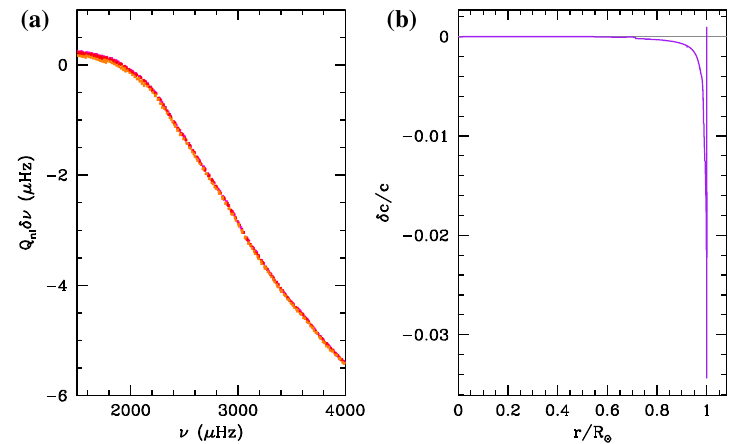
Fig. 8 a The scaled frequencies differences between a solar model constructed with the Eddington T – τ relation and one with the Krishna Swamy T – τ relation. Only differences of modes with (cid:2) < = 50 are shown. b The relative sound-speed difference between the two models. The differences are in the sense (Eddington–Krishna Swamy)